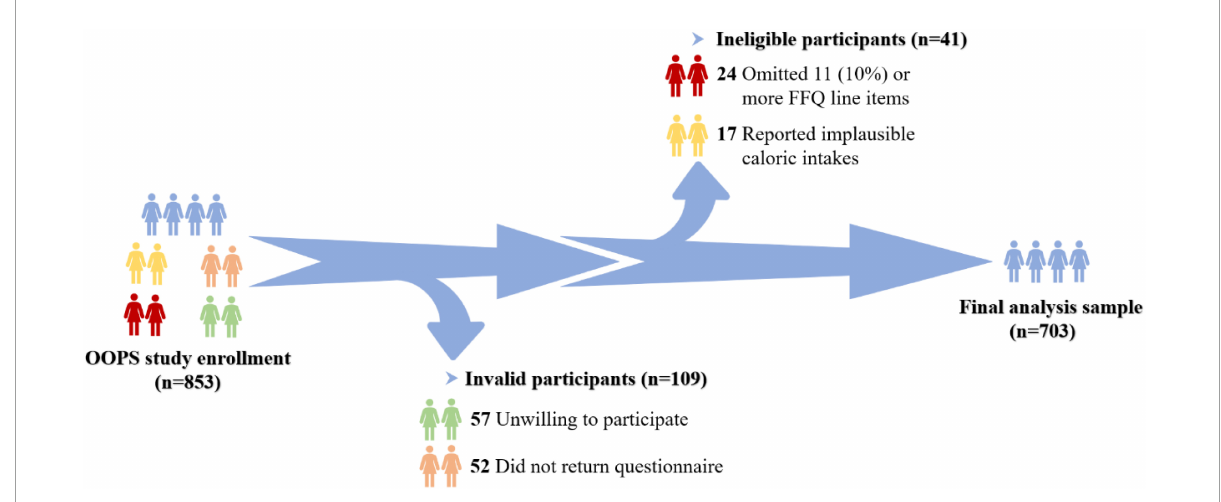
FIGURE1 Flow of participants through the Ovarian Cancer Follow-Up Study